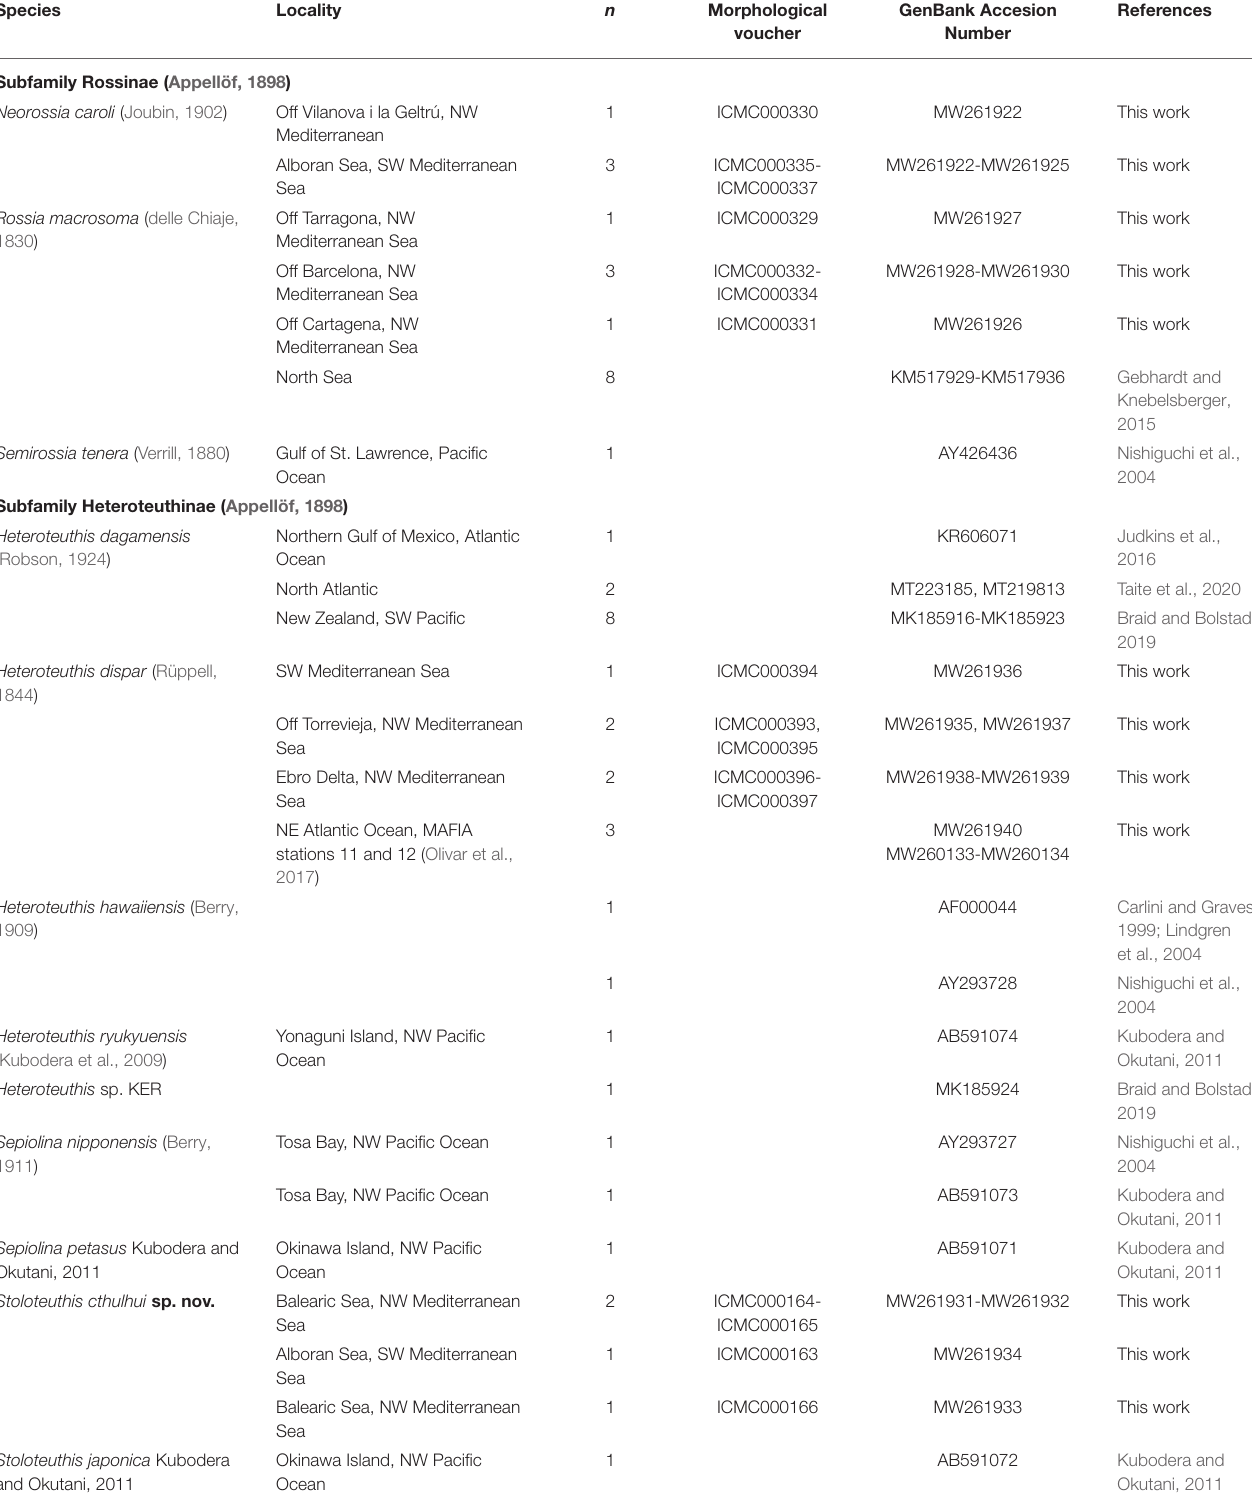
TABLE 1 | List of specimens used in this work, indicating the sampling locality, the number of studied sequences (n), and the GenBank Accession Numbers.